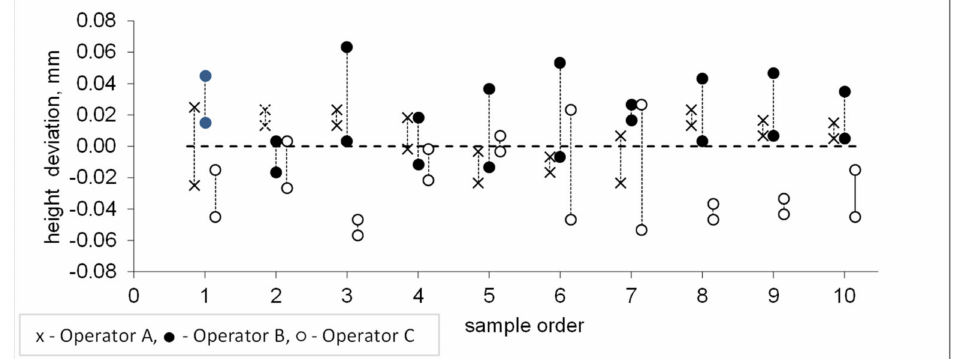
Figure 4. Modified GRR diagram comparing measurements of the individual